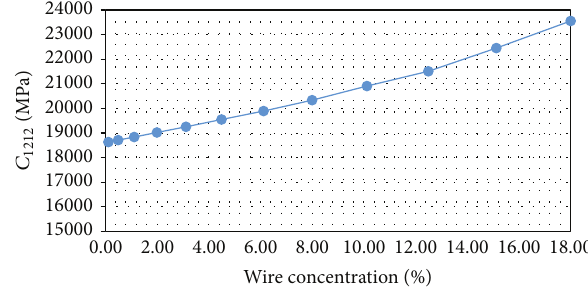
(0) 𝐶 1111 for reinforced plexiglas